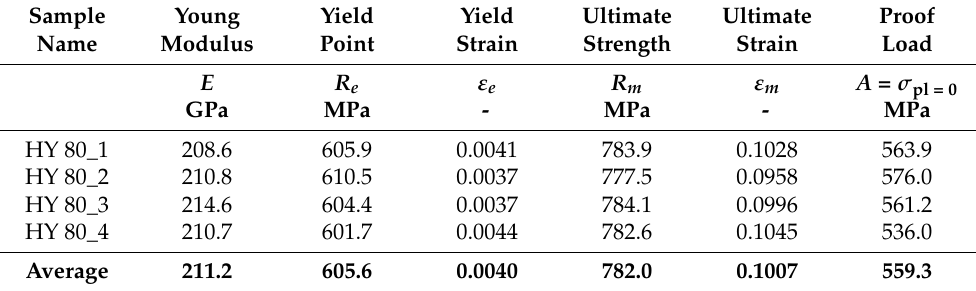
Figure 6. HY 80 σ true - ε pl true characteristics, strain rate 𝜀(cid:4662) = 0.0001 𝑠 (cid:2879)(cid:2869) . Table 2. Material constants describing HY 80 steel based on Formulas